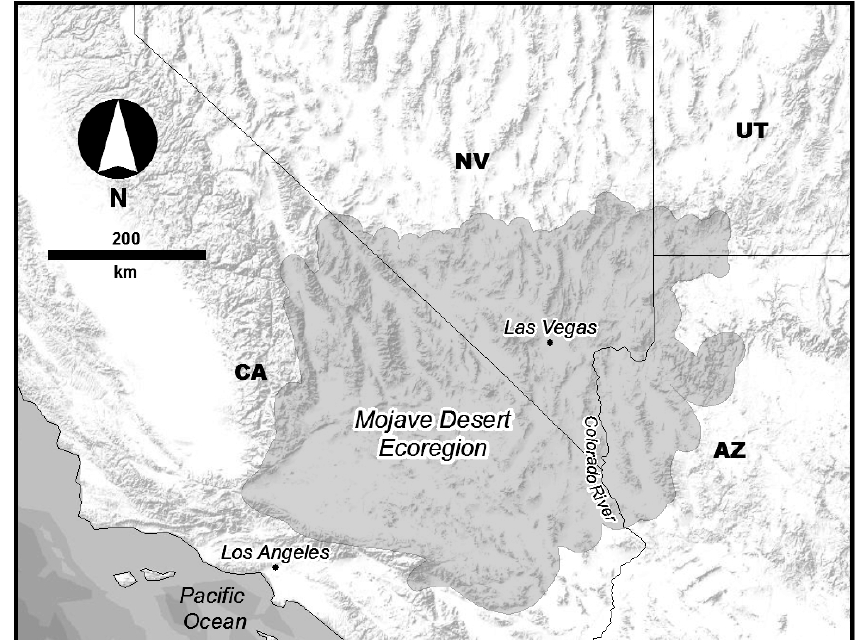
Figure 1. Study area used for thermophysical mapping. The Mojave Basin and Range Level III Ecoregion (Wiken et al., 2011) provides an ideal region for mapping surface thermophysical characteristics due its low vegetation cover, arid conditions, and high prevalence of cloud free days.